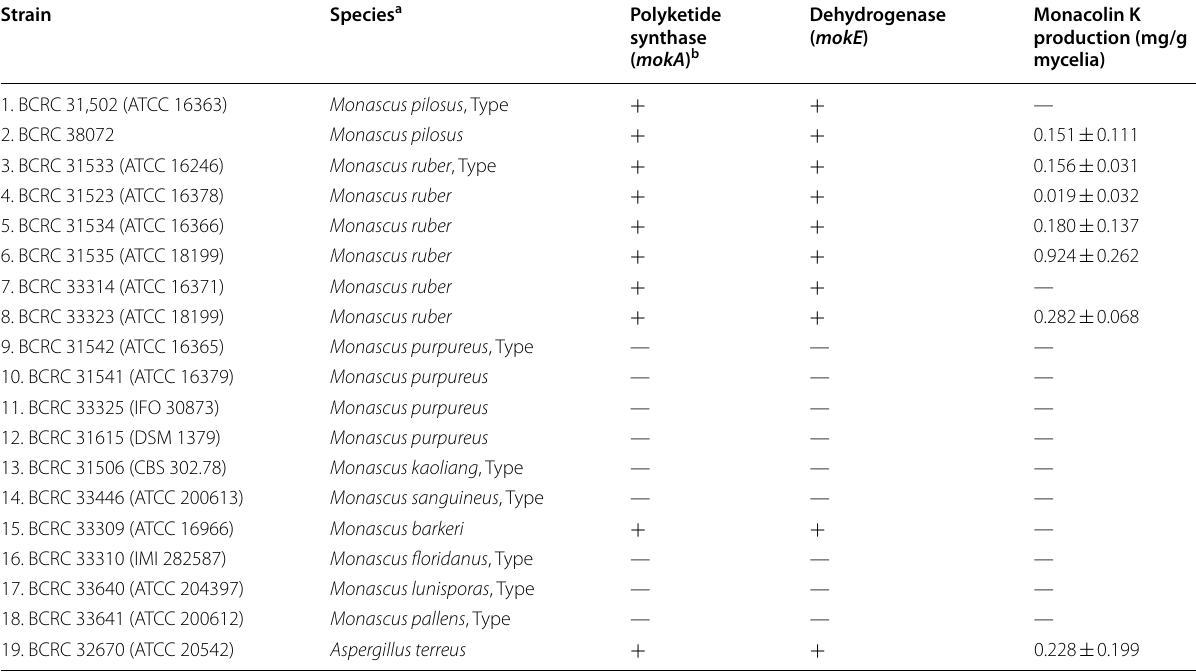
a “Type” indicates type strain b , positive;